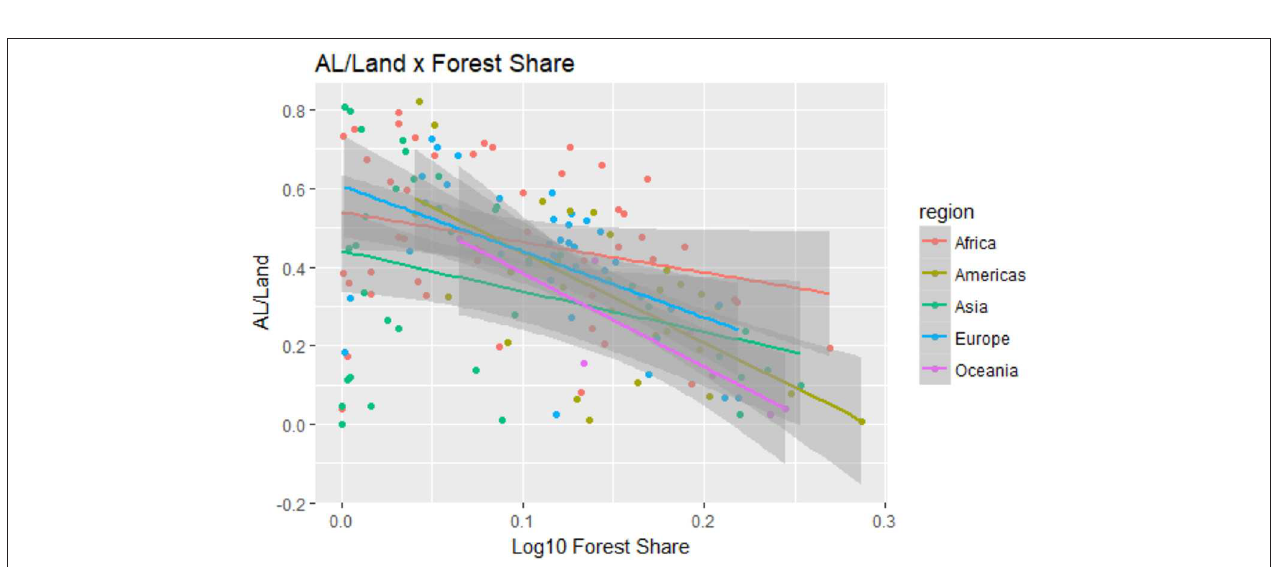
FIGURE 6 | Relationship of agricultural land ratio (a country’s agricultural land area/a country’s total land area) and forest ratio (a country’s forest area/a country’s total land area) in various